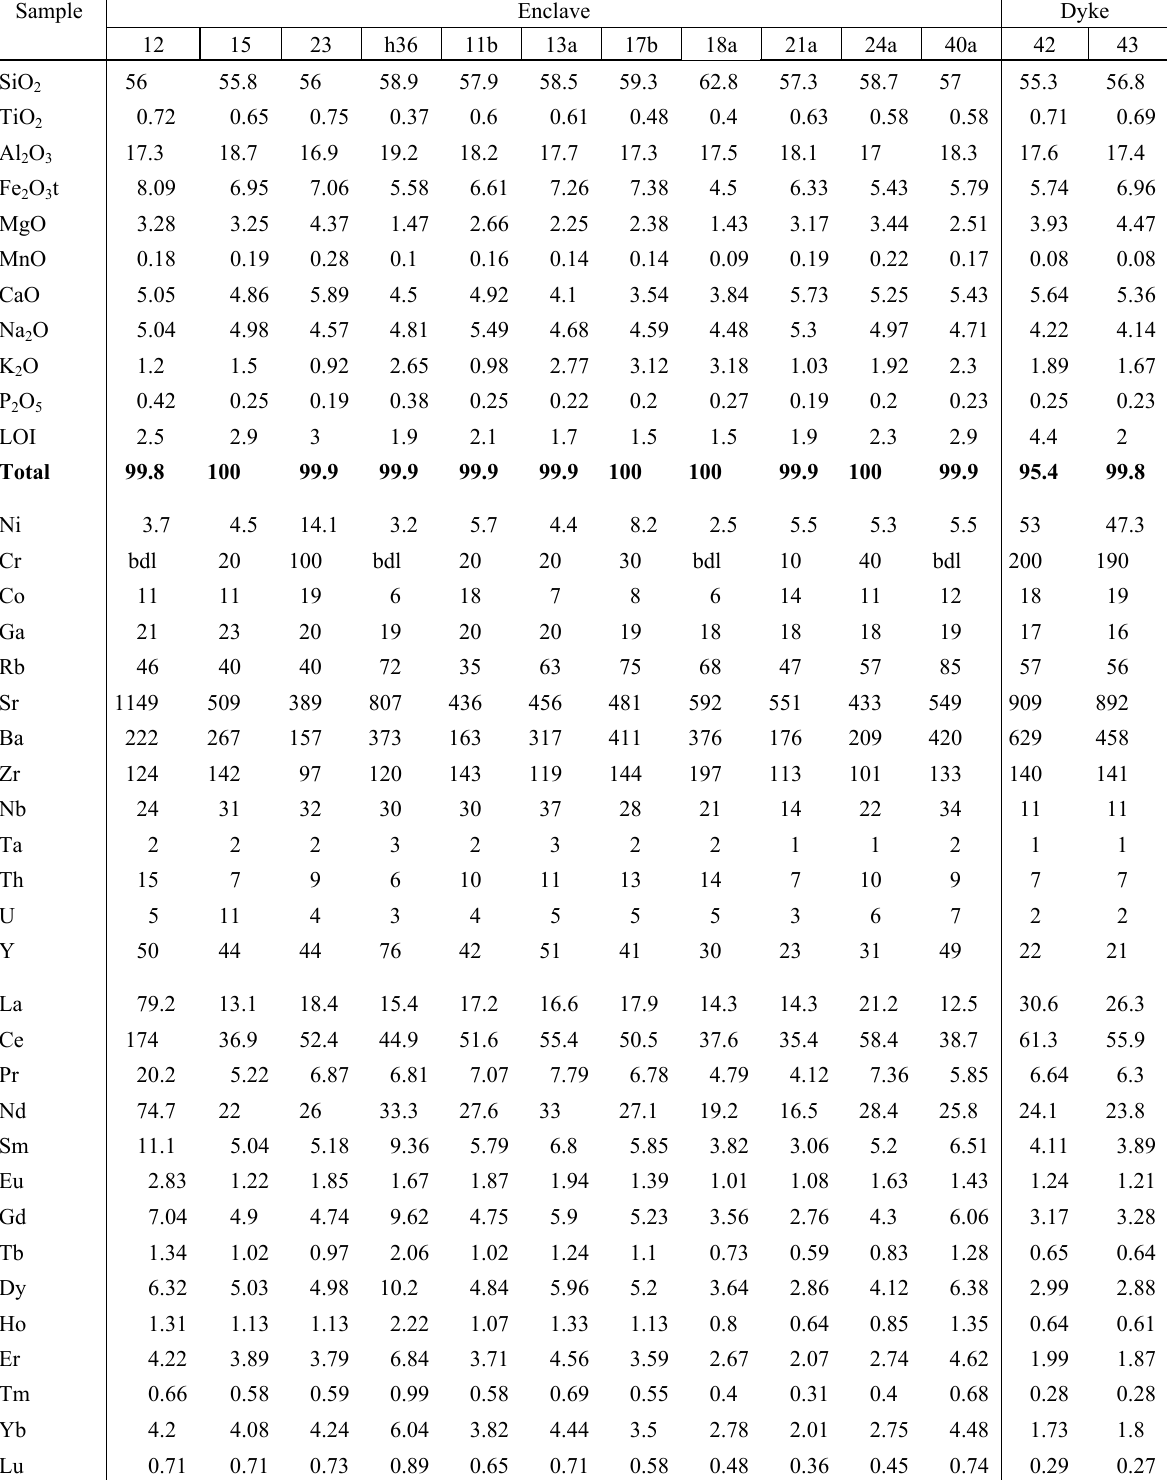
Table 1. Major (wt%), trace and rare-earth element (ppm) analyses of the Horoz pluton